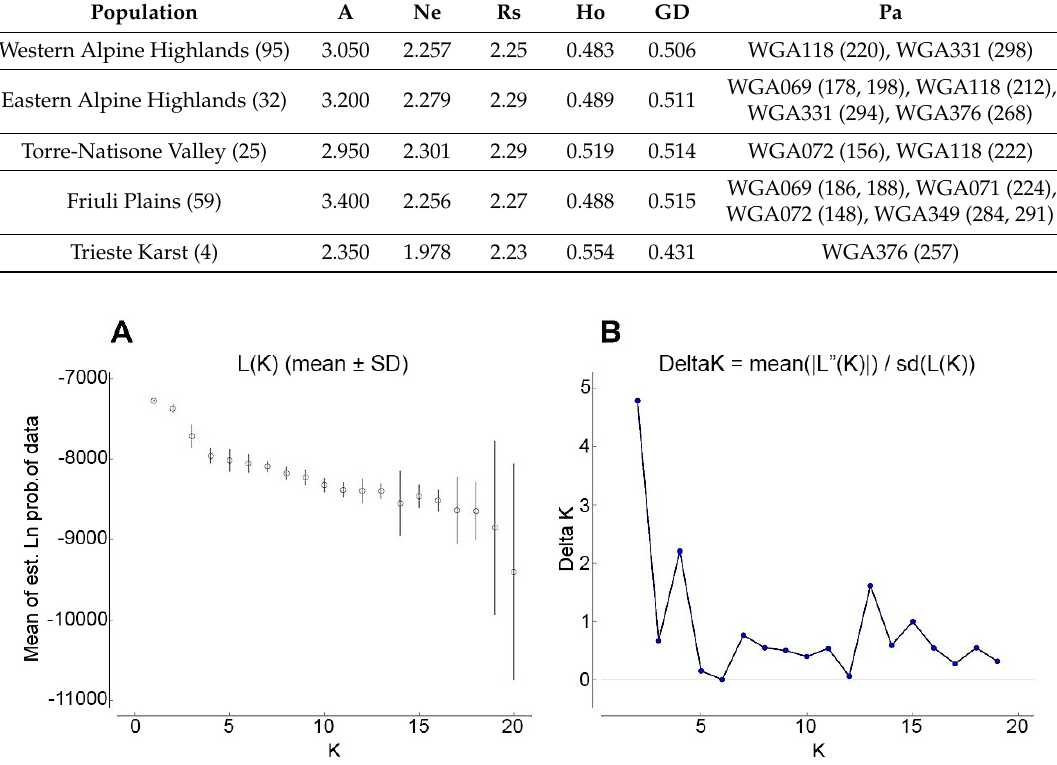
Figure 3. Inference of K, the most probable number of clusters, using STRUCTURE software, based on microsatellite analysis of 215 walnut samples. ( A ) Plot of mean likelihood L(K) and variance per K value from STRUCTURE on a dataset containing 215 individuals genotyped for 20 polymorphic microsatellite loci over 20 runs for each K value. ( B ) Plot of the ad hoc statistic Δ K, which is based on the rate of change of the log ‐ likelihood as K is increased)[50] Δ K tends to peak at the value of K that corresponds to the highest level of hierarchical substructure. The modal value of this distribution is the true K, here two clusters. Forests 2017 , 8 , 81